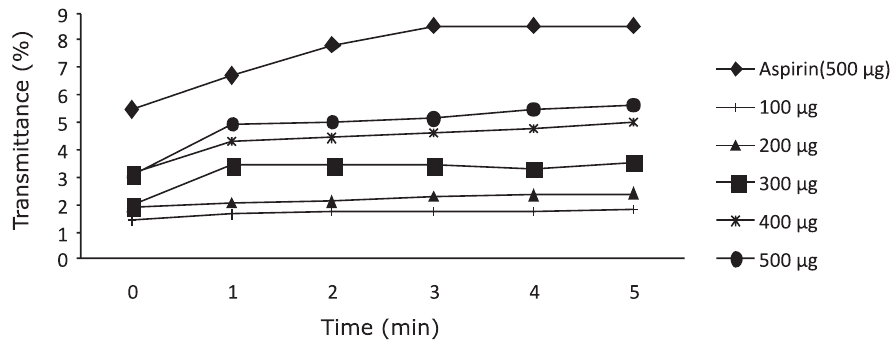
FIGURE 2 - Antiplatelet activity of hydroethanolic extract of pink Nelumbo nucifera flower extract (♦) antiplatelet activity of Aspirin at 500 µg/mL; ( È ) antiplatelet activity of hydroethanolic extract of pink flower extract at 100 µg/mL; (▲) antiplatelet activity of hydroethanolic extract of pink flower extract at 200 µg/mL; (■) antiplatelet activity of hydroethanolic extract of pink flower extract at 300 µg/mL; ( Û ) antiplatelet activity of hydroethanolic extract of pink flower extract at 400 µg/mL; (●) antiplatelet activity of hydroethanolic extract of pink flower extract at 500